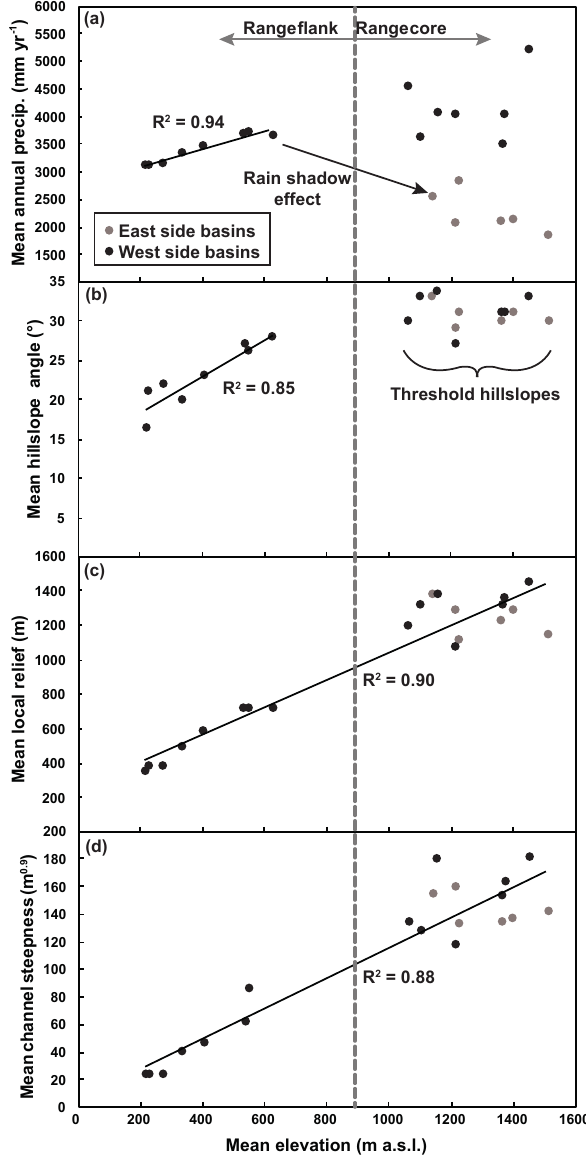
Figure 3. Comparison of the mean basin elevation with other basin averaged metrics. (a) Mean annual precipitation. (b) Hillslope an- gle. (c) Local relief (using a 5km diameter circle). (d) Channel steepness.